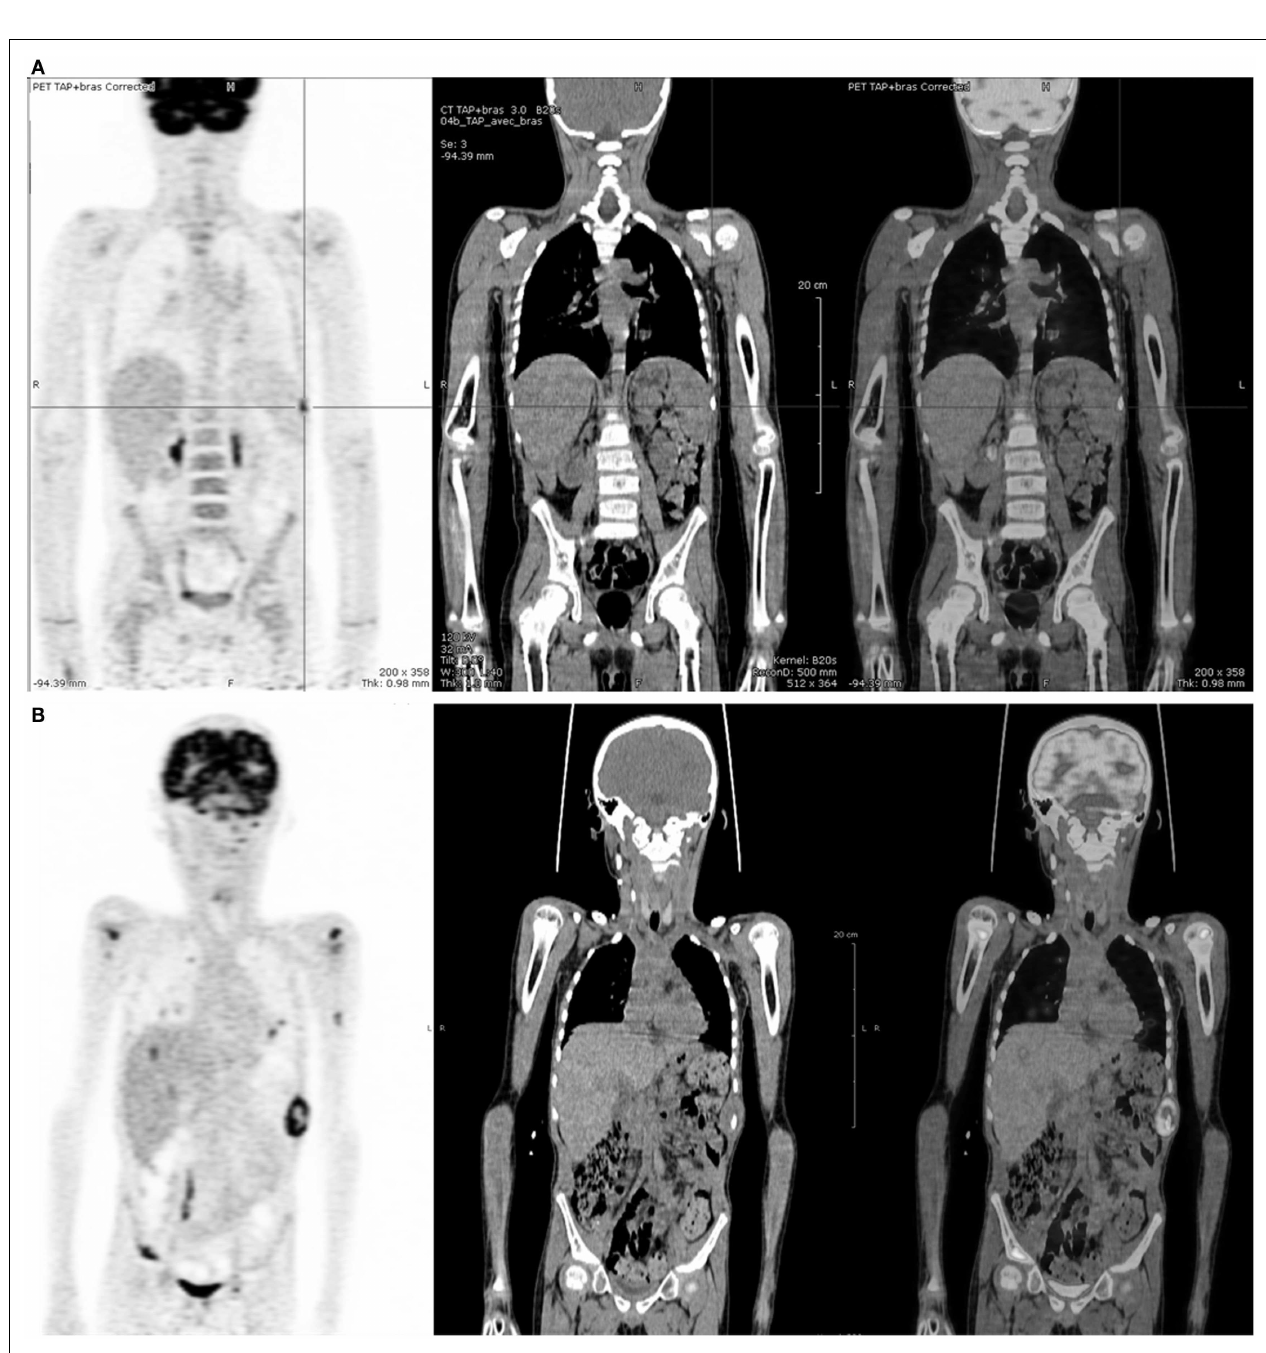
FIGURE 2 | Five-year-old boy with stage IV Burkitt’s lymphoma at relapse . (A) 18 FDG-PET after induction chemotherapy showing a nodular uptake on spleen whereas CI was negative. (B) 18 FDG-PET 12weeks later, showing disease